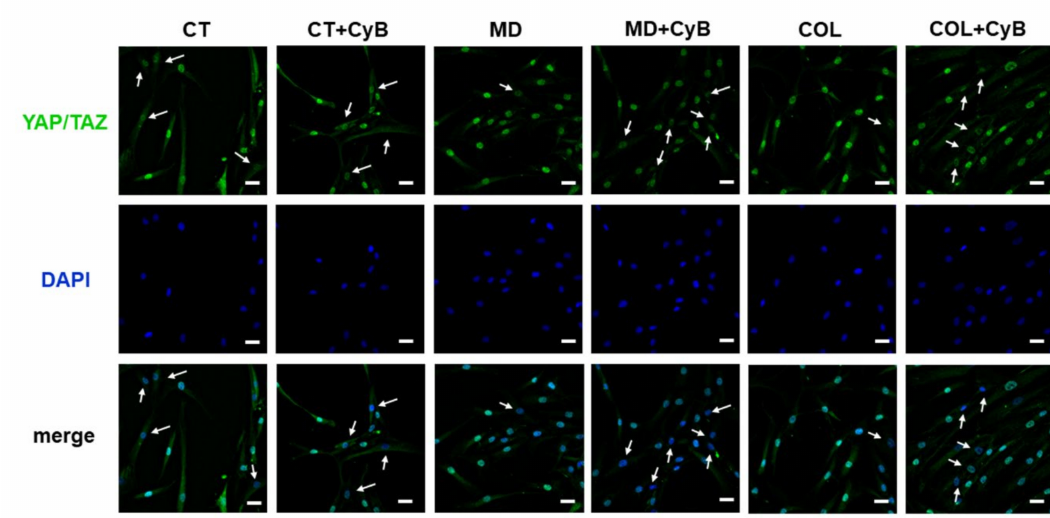
Figure 11. Immunofluorescence analysis for YAP / TAZ (green) in tenocytes cultured on MD and COL, compared to CT, before and after CyB treatment. The merged micrographs show that in tenocytes cultured on MD and COL, immunoreactivity is more evident in the nucleus, while, after CyB treatment and in CT, immunoreactivity is mostly in the cytoplasm and nuclei are more blue, suggesting that the presence of MD and COL induces YAP / TAZ activation, while mechanical stress deprivation induces a phenotype more similar to CT cells. Original magnification: 60 × . Scale bar: 20 µ